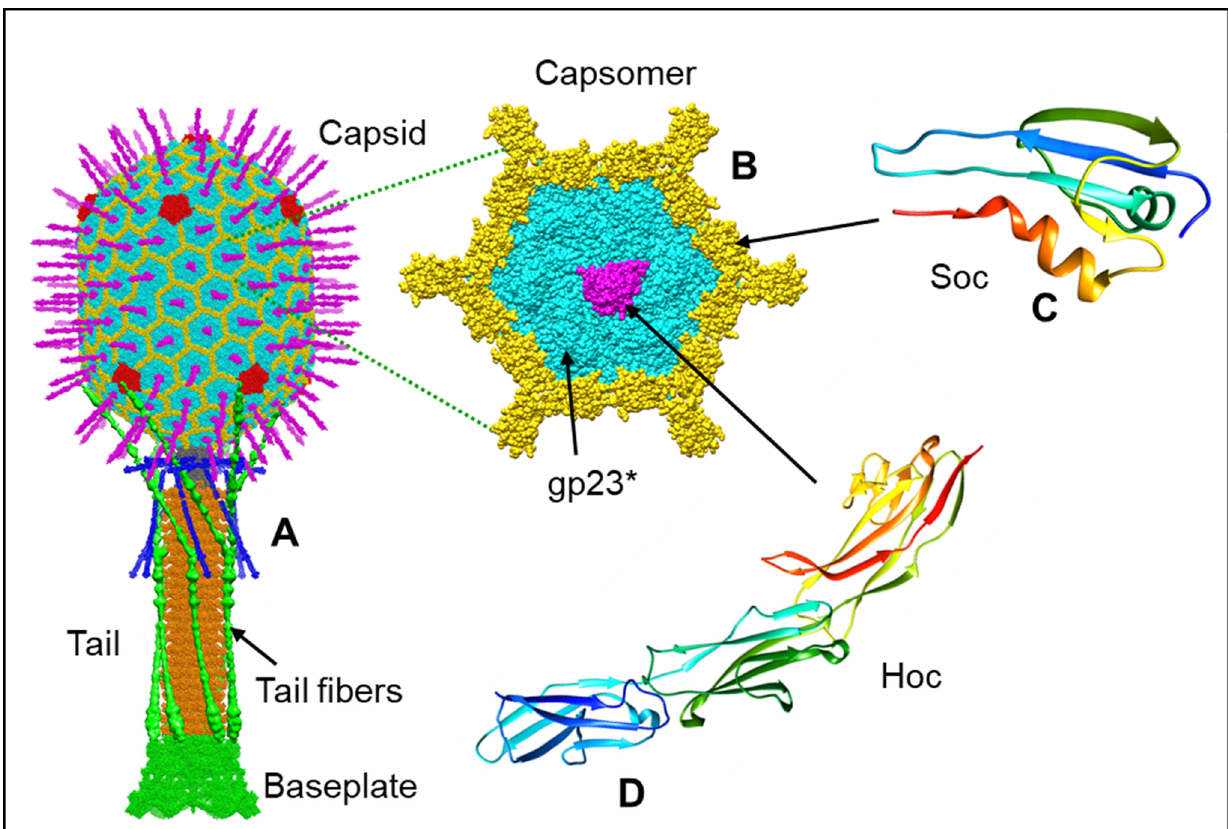
Figure 1. Structural model of bacteriophage T4 virion. The bacteriophage T4 virion ( A ) has a 120 × 86 nm prolate capsid packaged with ~171 kb linear double-stranded genomic DNA. The major capsid protein, gp23*, is shown in cyan; the vertex protein, gp24*, in red; the Soc protein in yellow; and the Hoc protein in magenta. A ~140 nm contractile tail with a baseplate is attached to the head through a dodecameric portal-neck connector. Six ~160 nm long tail fibers emanating from the baseplate are shown here in the “up” position. One of the hexameric capsomers ( B ) is enlarged to depict the arrangement of gp23*, Soc, and Hoc subunits. The atomic models of Soc ( C ) (PDB ID 5VF3) and of Hoc three Ig-like domains ( D ) (PDB ID 3SHS) are shown in rainbow colors.